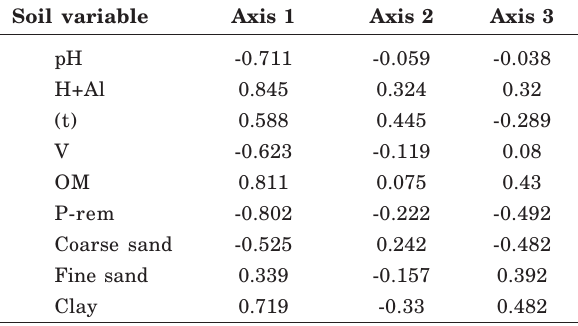
Table 2. Pearson correlation coefficients